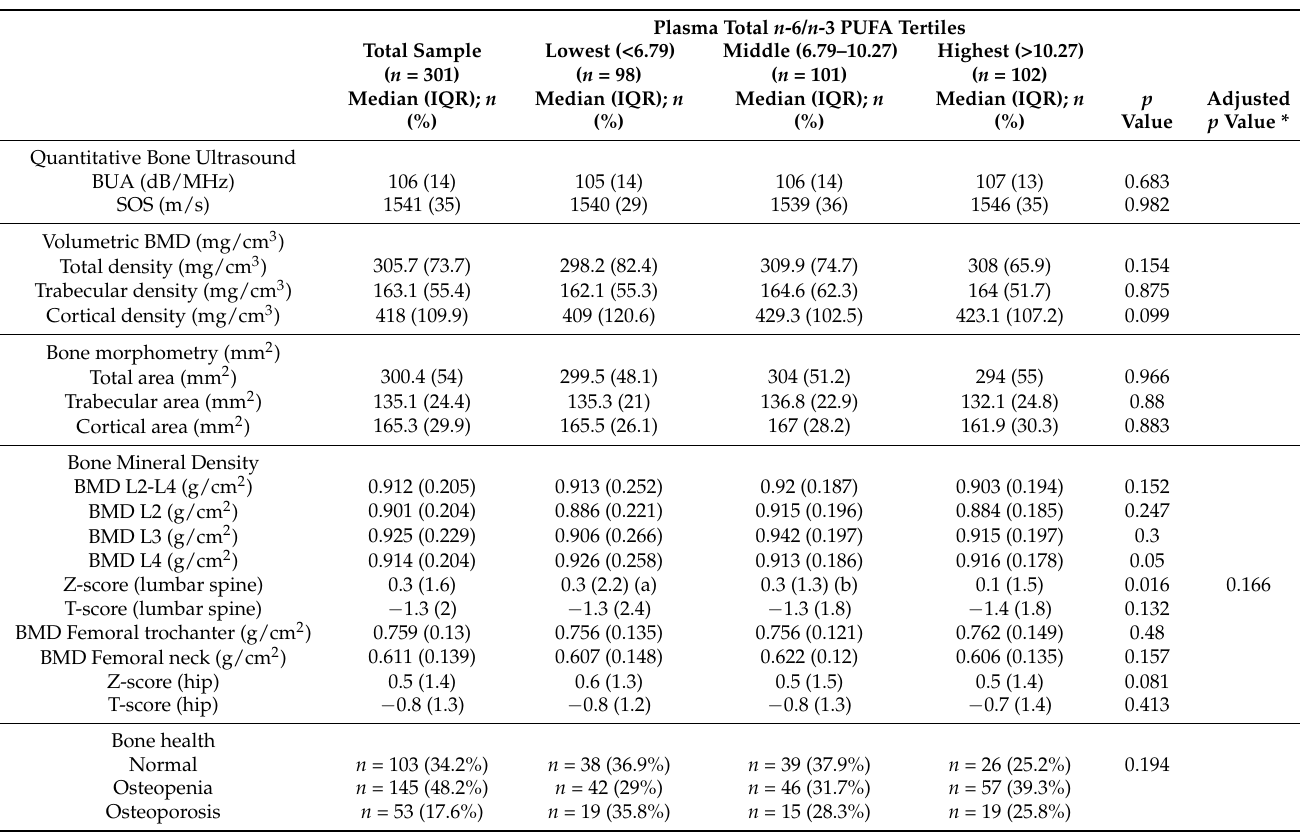
Table 5. Bone parameters by tertile of plasma n -6 PUFA/ n -3 PUFA ratio.